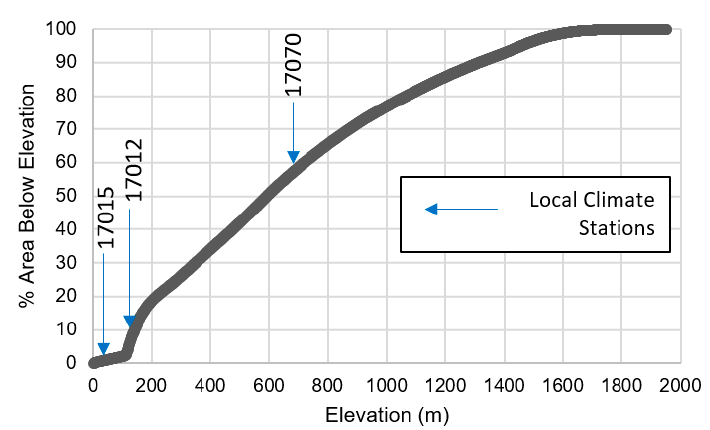
Figure 2. Hypsometric curve and elevation of the local climate stations.